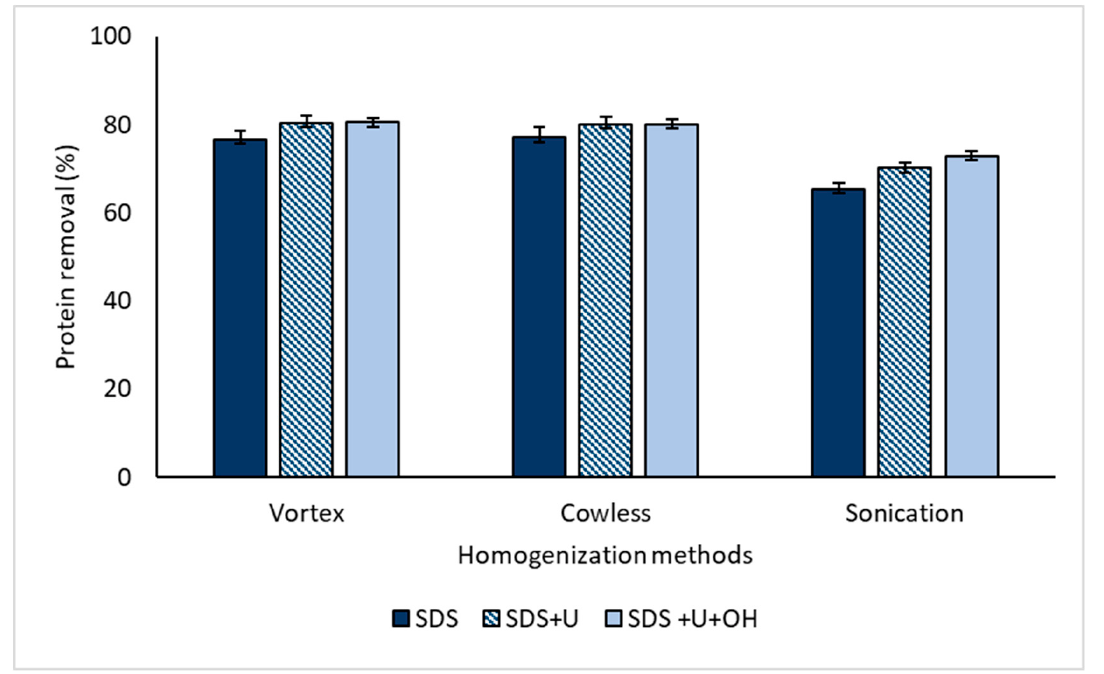
Figure 9. Effect of homogenization methods on protein removal (2% concentration of deproteinizing agents).